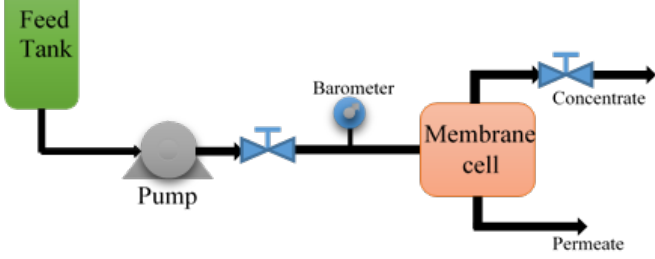
Figure 1. Schematic of the microfiltration setup.